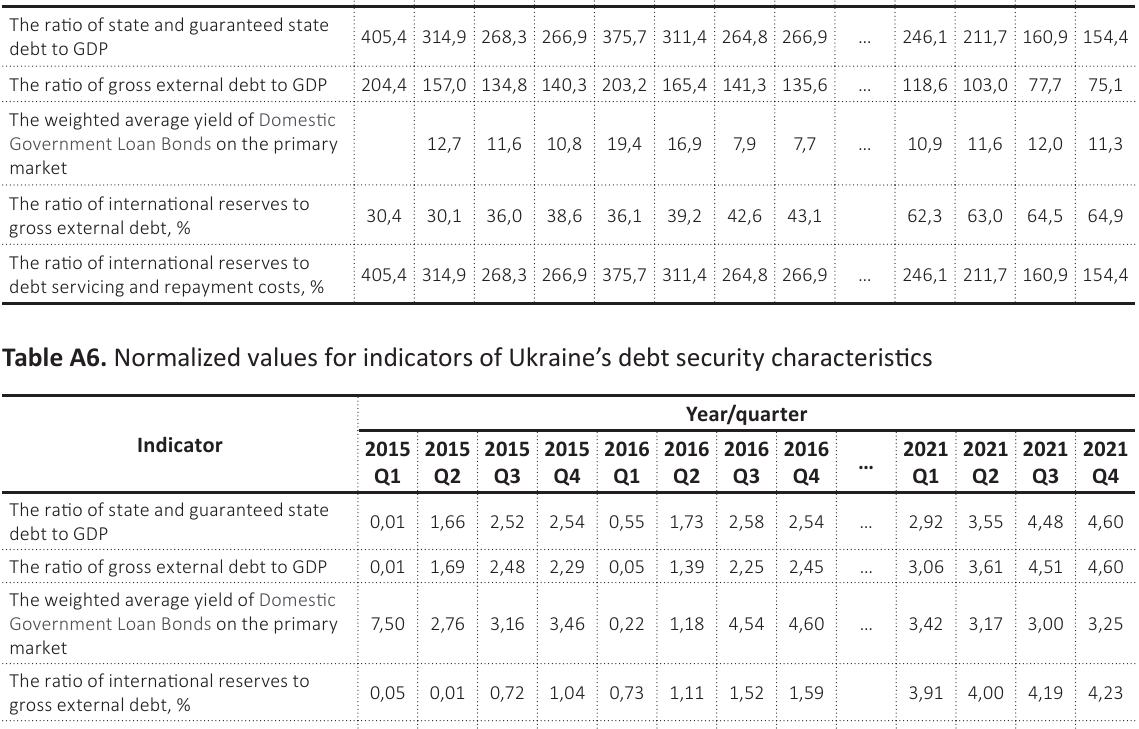
Table А5. Information base for the study of debt security in Ukraine Indicator